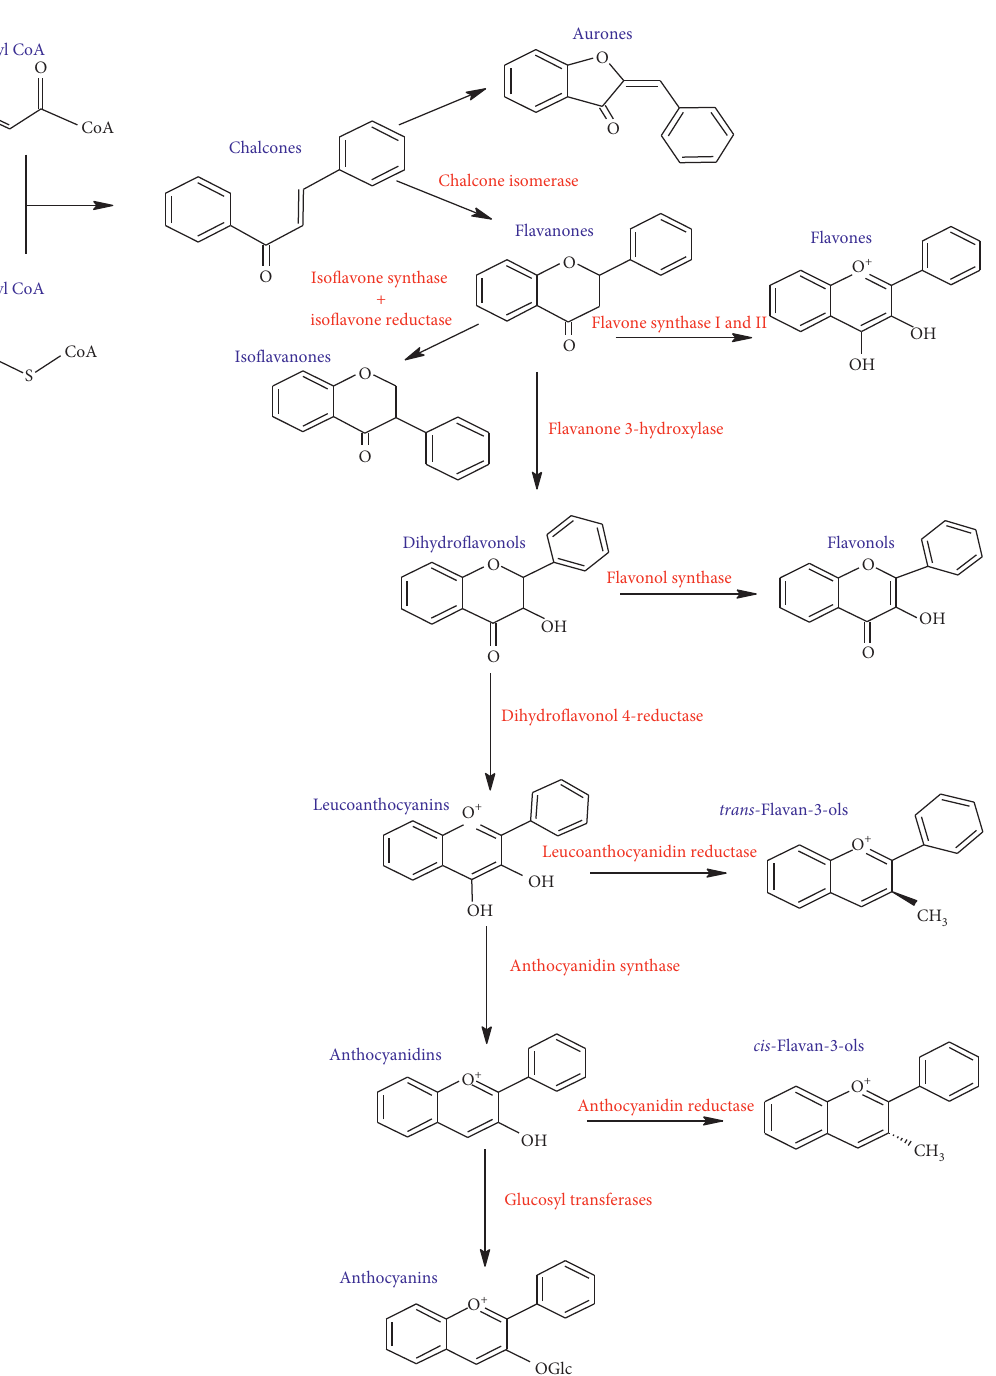
Figure 2: Schematic representation of the flavonoid biosynthetic pathway [3,